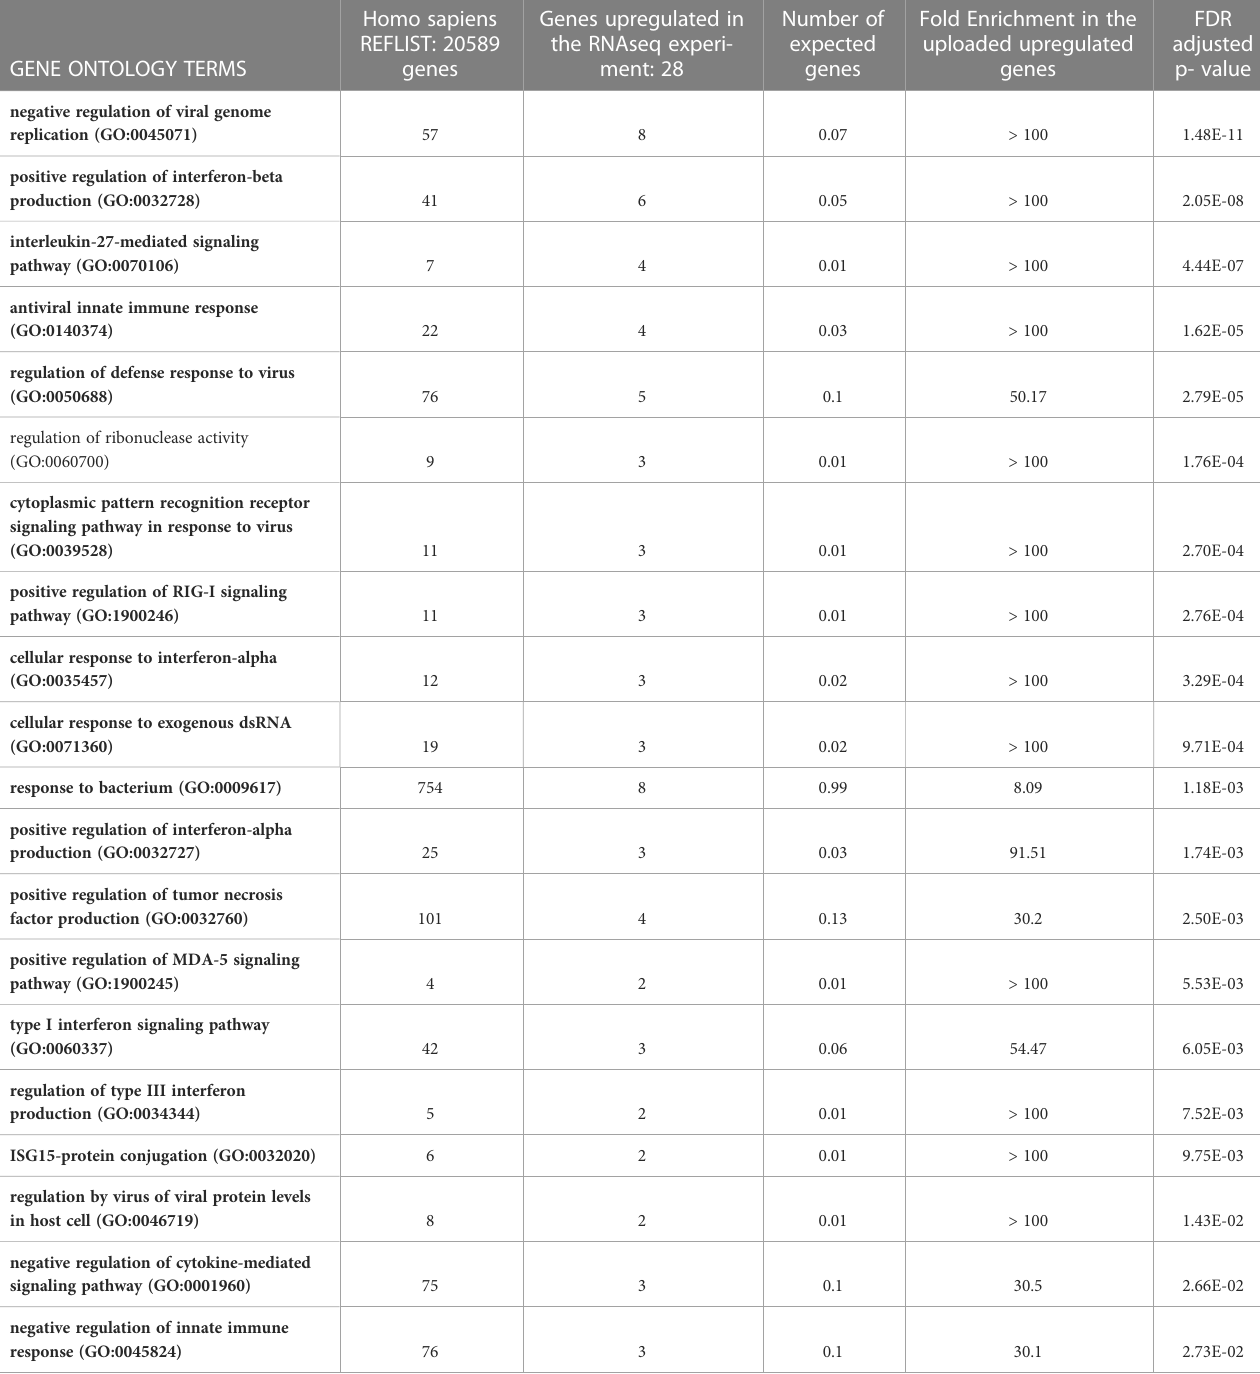
TABLE 1 Genes differentially upregulated (at least 2-fold) in HAP-1, control, poly(I:C)-treated cells compared to HAP-1, control, mock-treated cells, classi fi ed using Gene Ontology according to the biological process they are involved in.